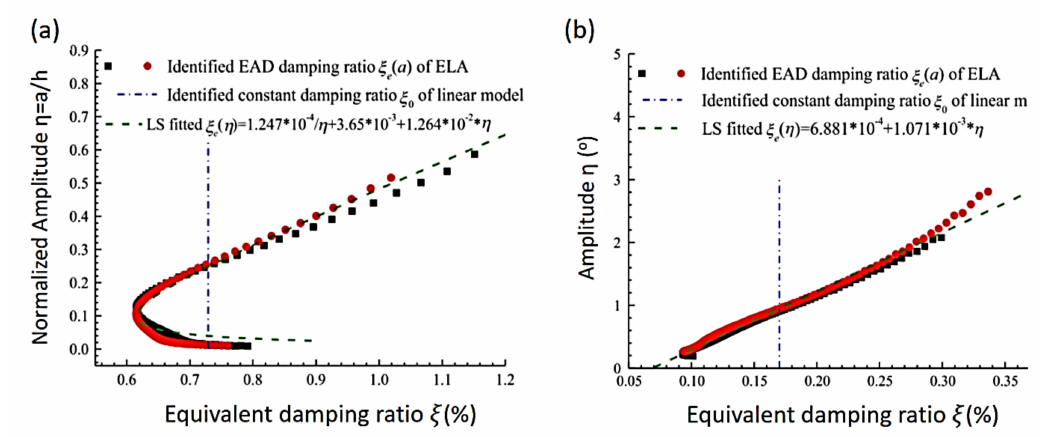
Figure 3. Comparison of identified equivalent amplitude-dependent damping and natural frequency of the spring-suspended sectional models. ( a ) Bending mode; ( b ) torsional mode [81].